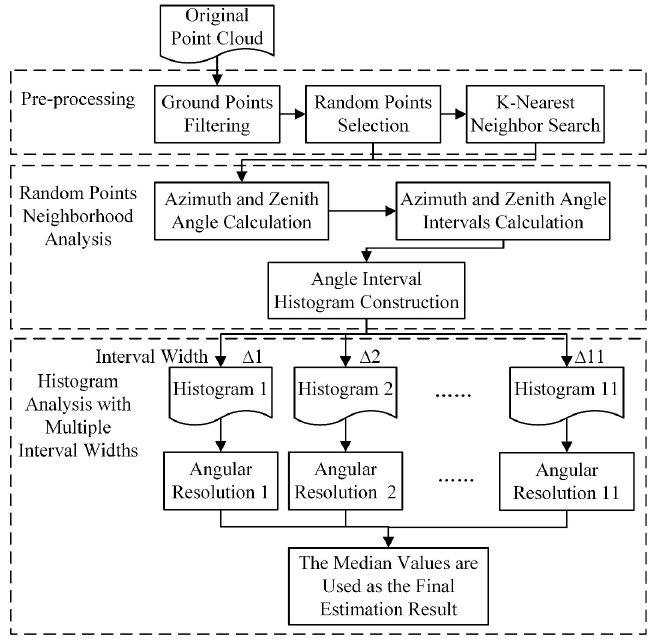
Figure 2. Workflow of NARP.